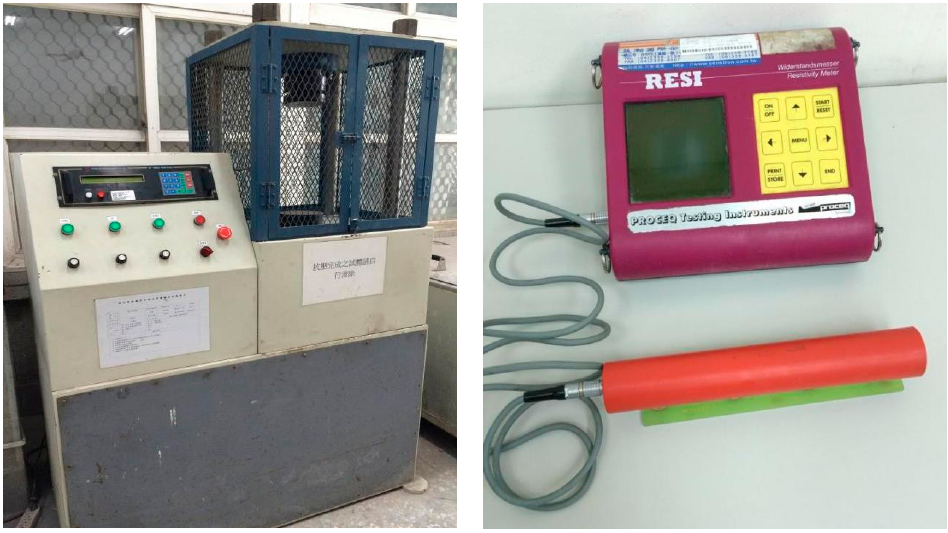
Figure 1. Test equipment. ( a ) Compressive strength-testing machine. ( b ) Four-pole resistance-measuring instrument.